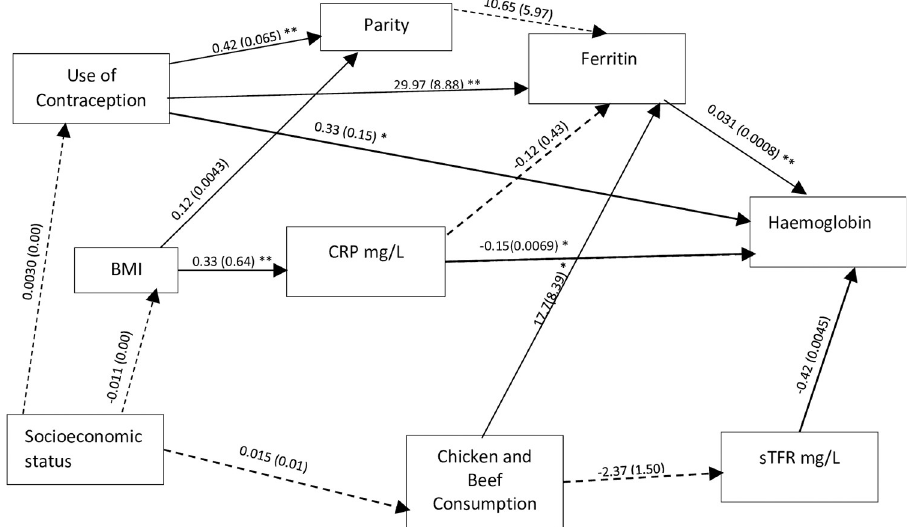
Fig 1. SEM framework for anaemia outcome. The solid lines represent significant direct effects and the dashed line is not a significant direct effect. All values are coefficients with standard errors in parenthesis. Significance levels: *** P < 0.001, ** P < 0.01, * P < 0.05. The model statistics were the Root Mean Square Error of Approximation for: 0.025, the Comparative Fit Index: 0.969, the Tucker-Lewis Index: 0.947 and SRMR: